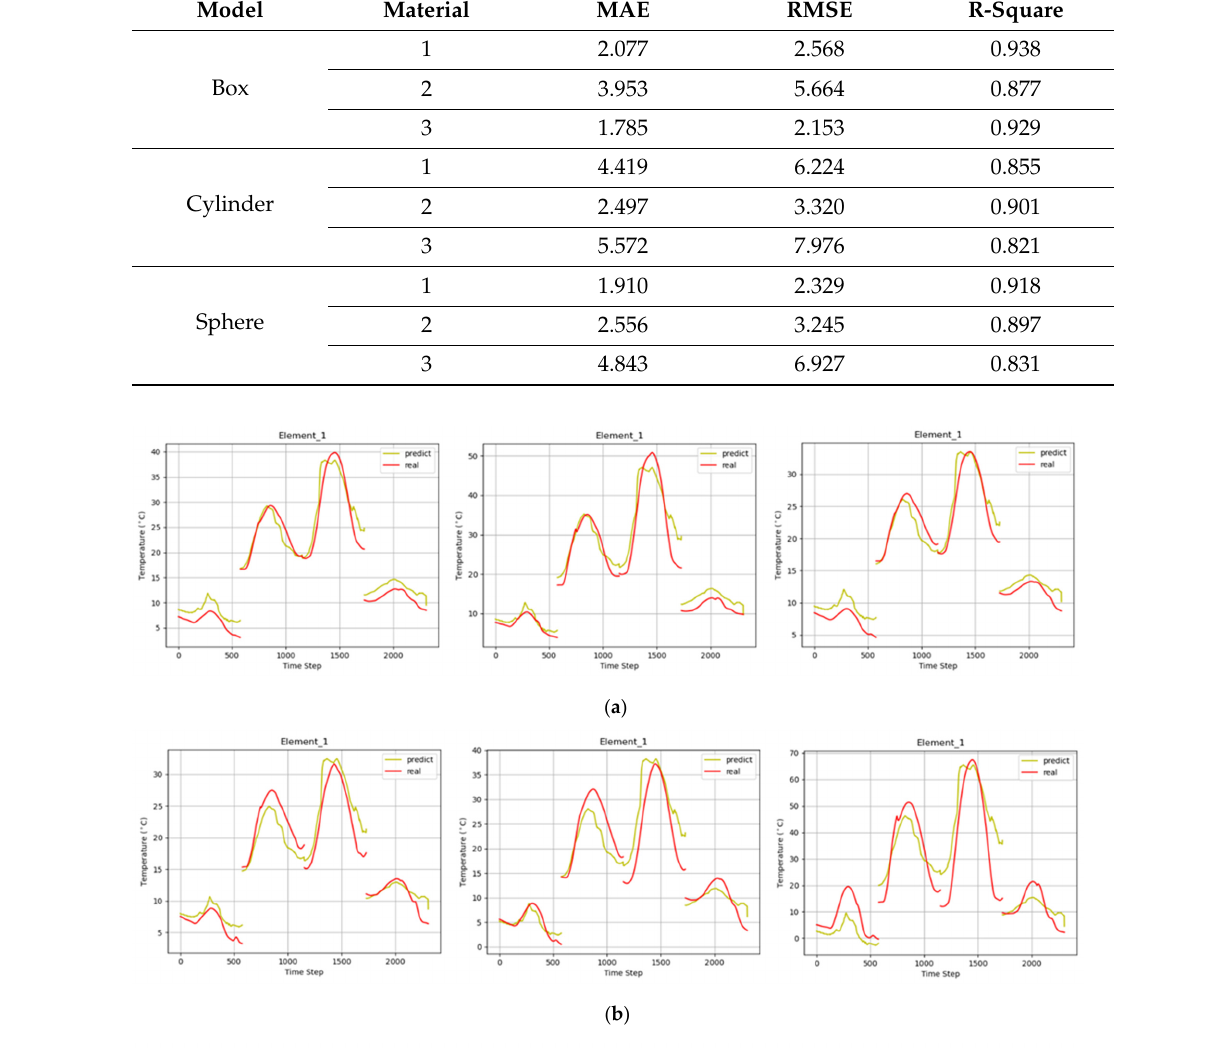
Figure 12. Complex house model with 5660 patches and 30 parts: ( a ) geometric structure; ( b ) tem- perature field distribution at a given moment. Table 4. MTPHNet’s generalization performance for temperature field prediction of complex ob- jects.